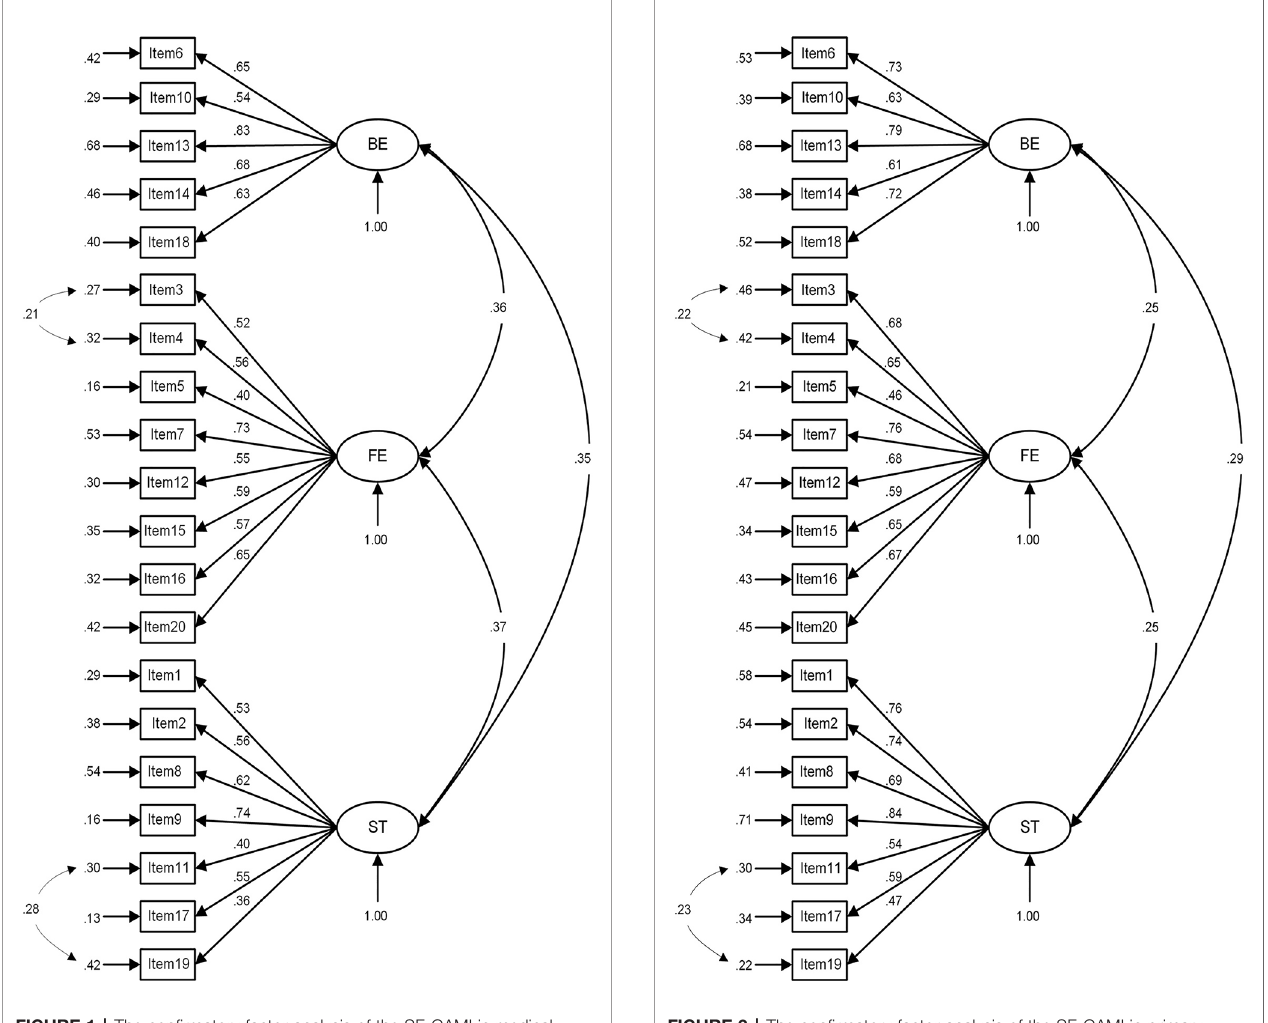
FIGURE 1 | The con fi rmatory factor analysis of the SF-CAMI in medical students.